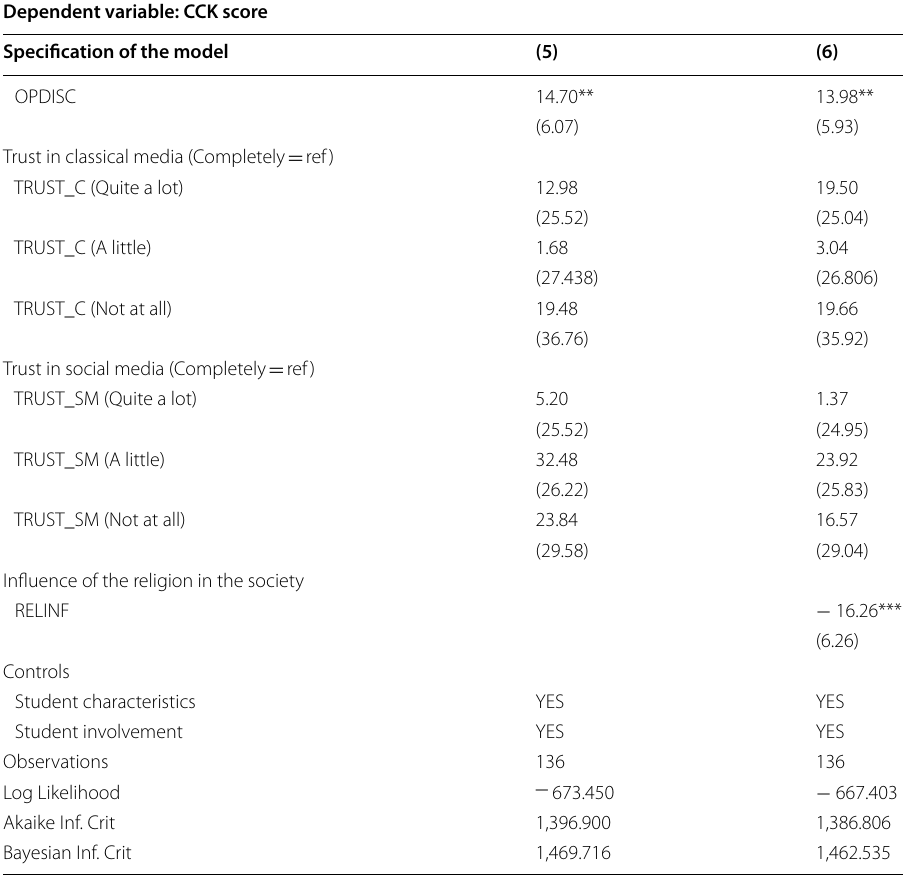
Table 5 Mixed effects models: Subset non-Estonian students in Estonian